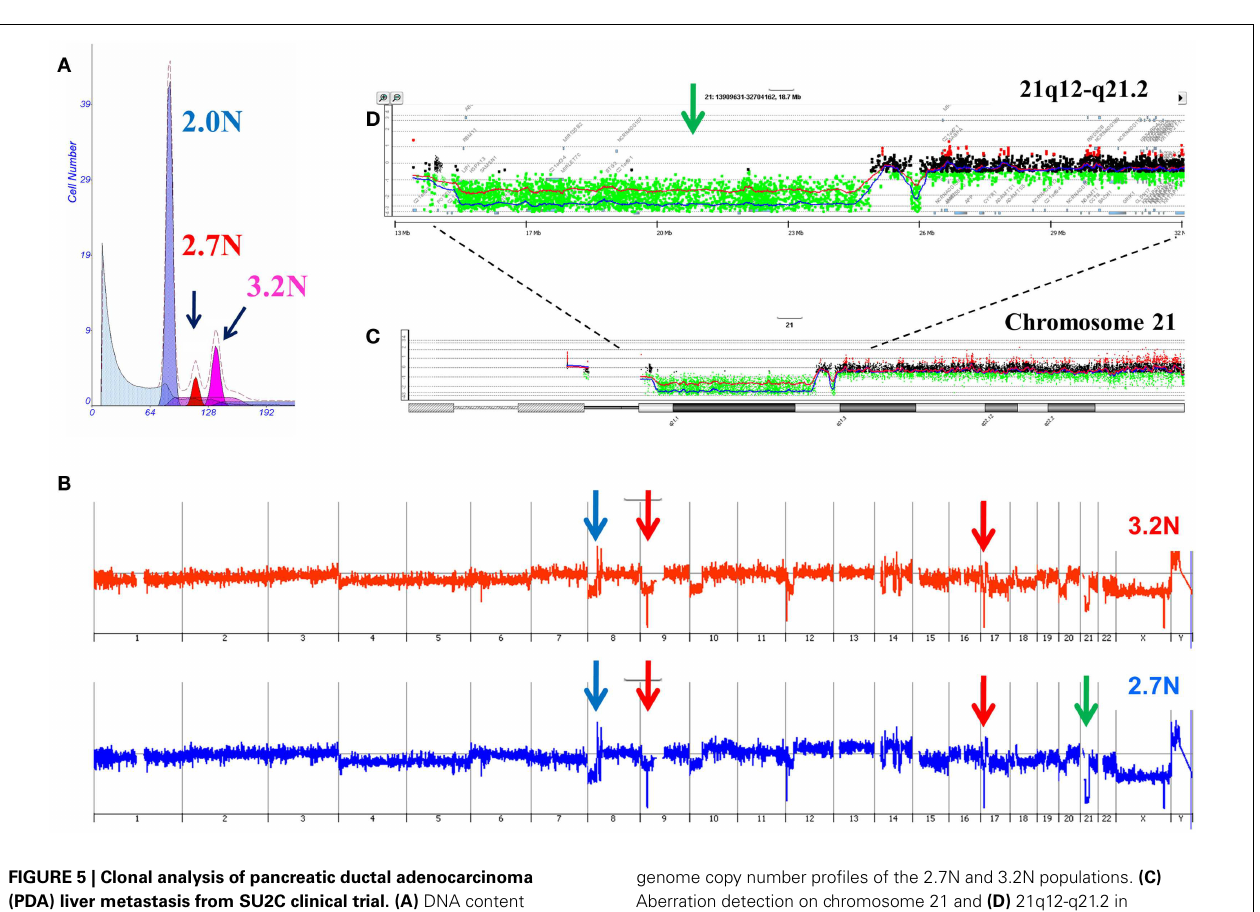
FIGURE 5 | Clonal analysis of pancreatic ductal adenocarcinoma (PDA) liver metastasis from SU2C clinical trial. (A) DNA content flow sorting identified and purified a diploid and two distinct aneuploid (2.7N, 3.2N) peaks in the single biopsy. (B) Whole